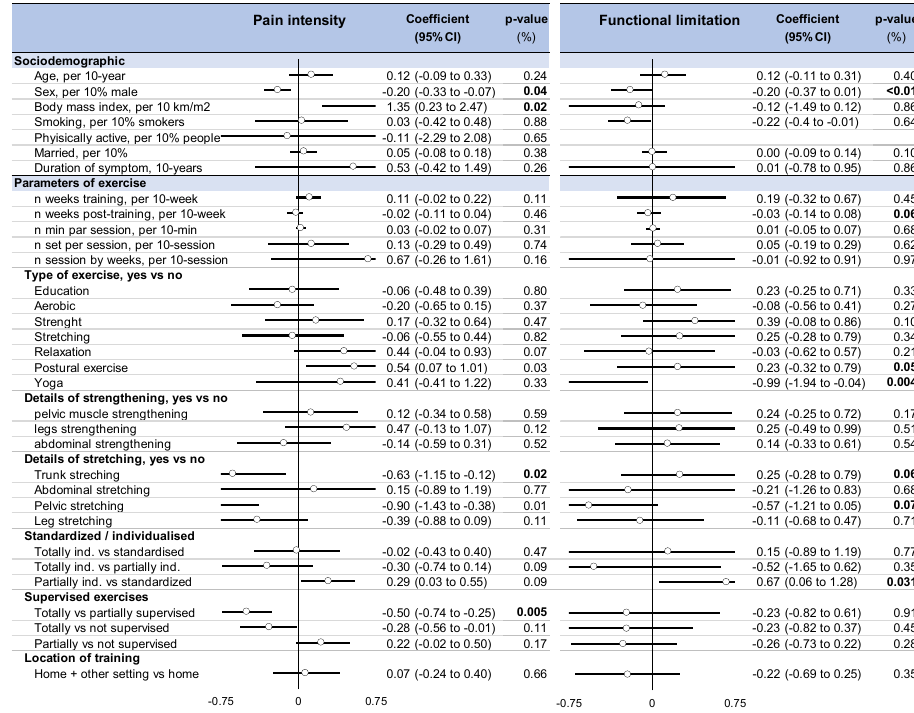
Figure A5. Metaregressions (i.e., putative influencing variables on pain intensity and functional limitation following home-based exercise in LBP), using only the last time of follow-up.